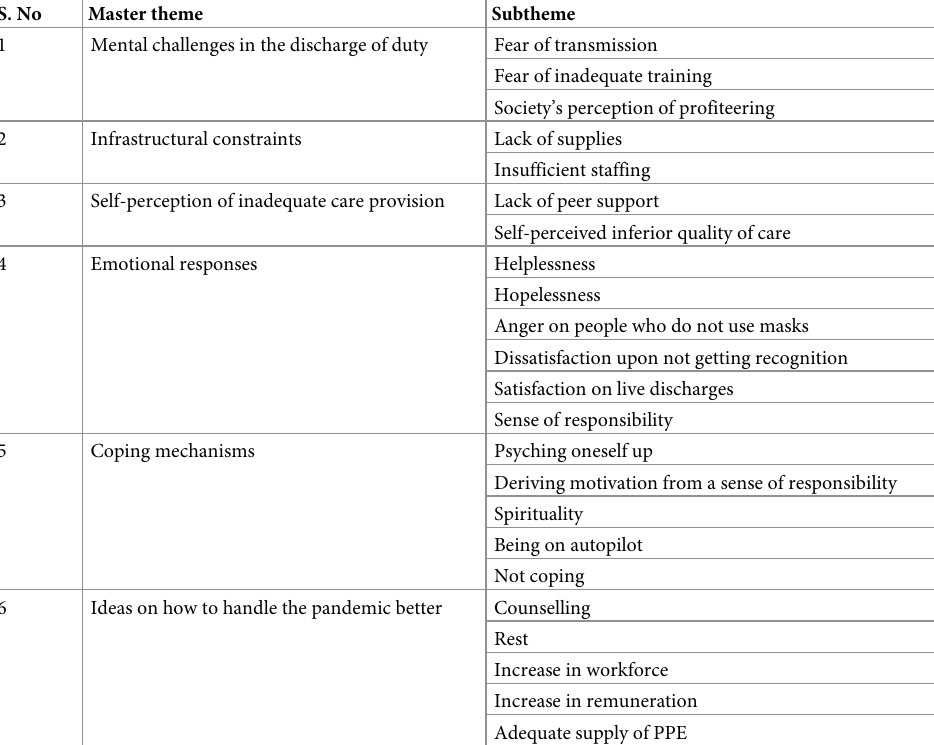
Table 2. Outline of master themes and